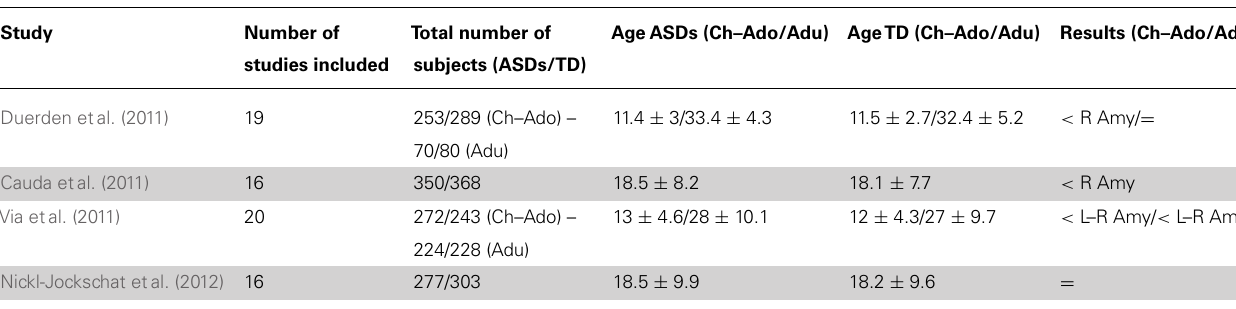
Table 1 | Summary of meta-analyticVBM results in the amygdala.